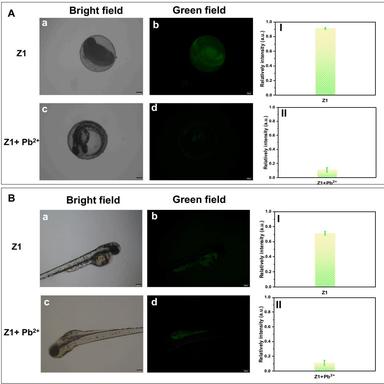
Schematic diagram of Z1 for detection of exogenous Pb2+ in living animals. A. Fluorescence imaging of Z1, Z1 + Pb2+ in zebrafish embryos. (a). Bright field image of Z1 in zebrafish embryo. (b). Green channel image of Z1 in zebrafish embryo. (c). Bright field image of Z1 + Pb2+ in zebrafish embryo. (d). Green channel image of Z1 + Pb2+ in living zebrafish embryo. I. The relatively intensity of probe Z1 in living zebrafish embryo. B. Fluorescence imaging of Z1, Z1 + Pb2+ in living zebrafish. (a). Bright field